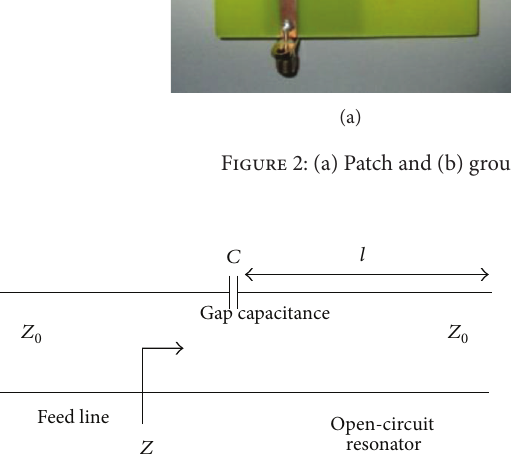
Figure 3: Equivalent circuit of the microstrip gap coupling.